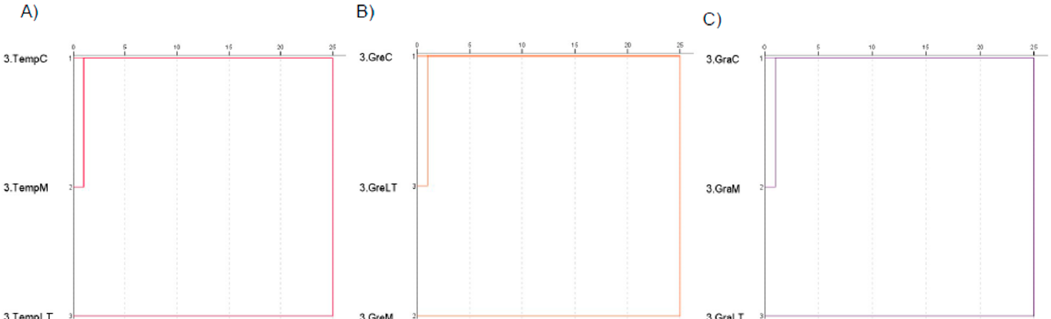
Figure 7. Hierarchical clusters assessed with average oenological and colour parameters of control